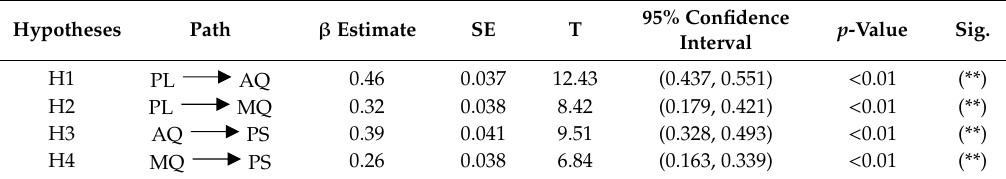
Table 4. β estimates for testing hypotheses 1–4.